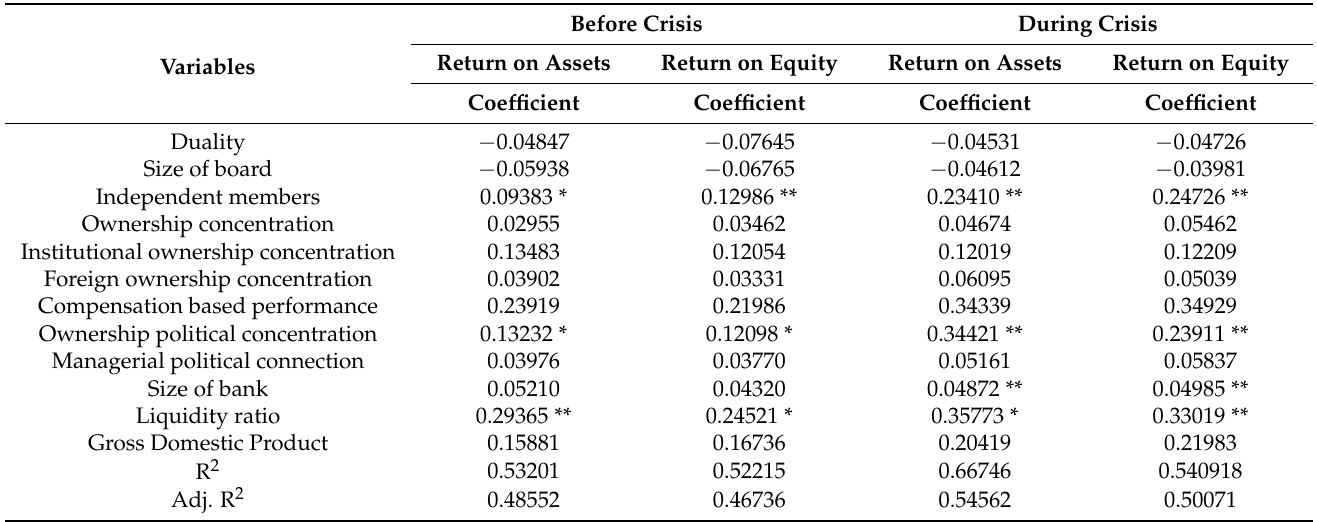
Table 7. Two-Stage Least Squares Regressions of ROA and ROE on Corporate Governance Variables and Institutional Variables Before the COVID-19 Crisis and During the COVID-19 Crisis.